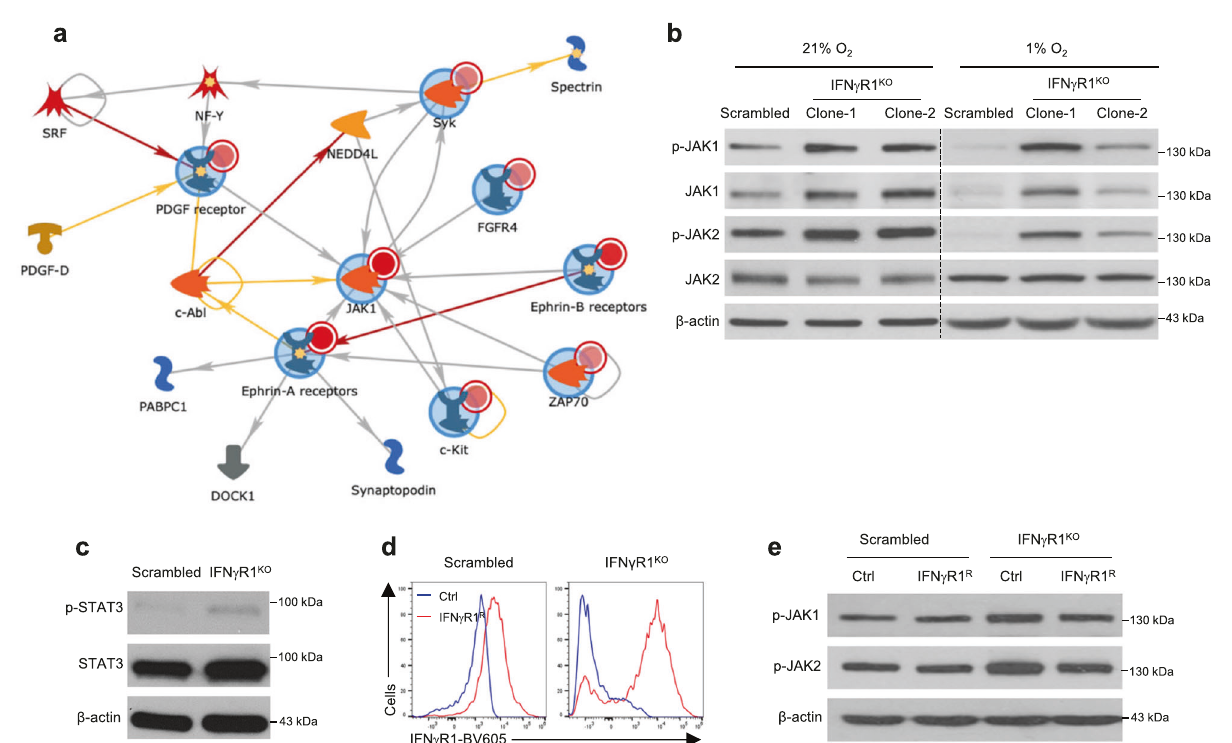
Fig. 3 | Constitutive activation of JAK1/2 in IFN γ R1 KO melanoma cells. a Identi fi cation of a JAK1/2-centric network of activated protein tyrosine kinases in IFN γ R1 KO cells by kinomic analysis. Input nodes (kinases) with large blue circles around them and smaller red circles on the top right corner indicate increased activityinIFN γ R1 KO cells.Arrowheadsdenotethedirectionofinteractionandcolors of the lines indicate the type of interaction (yellow: positive; red: negative; gray: context-dependent). b ScrambledandIFN γ R1 KO cellswereculturedundernormoxic (21% O 2 ) or tumor microenvironment-mimicking hypoxic (1% O 2 ) culture